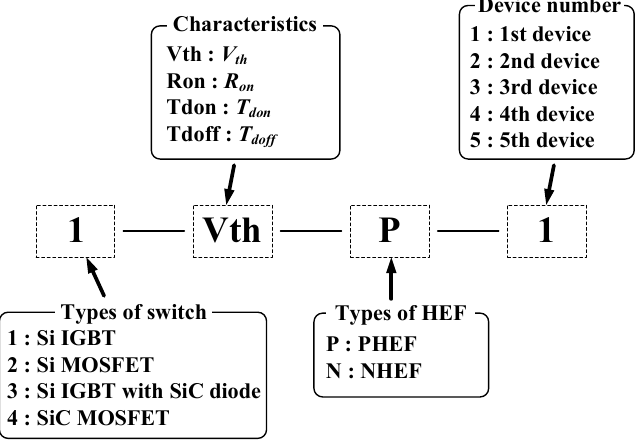
Figure 6. Device naming rule in this paper.